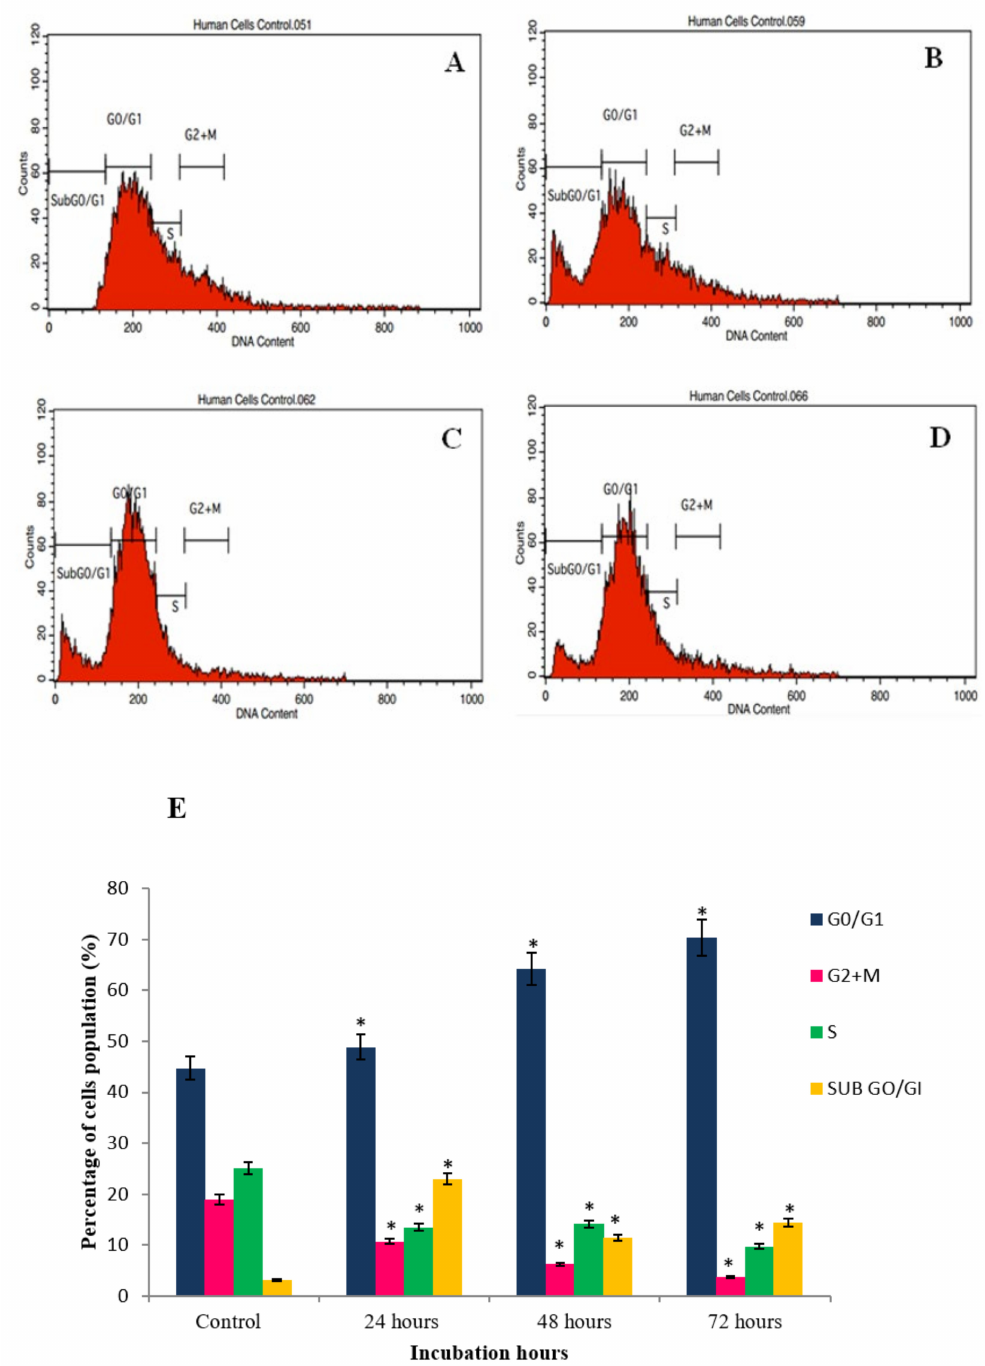
Figure 7. Cell cycle arrest histogram of GNST-ITC-treated MCF-7 cells at 5.02 µ M in a time-dependent manner by flow cytometry: ( A – D ) control and 24 h, 48 h, and 72 h treated cells respectively. ( E ) Bar chart shows percentage of cells distribution after the treatment. Values are presented as means ± SD of triplicate experiments. Significant di ff erence ( p < 0.05) as compared to control is indicated by